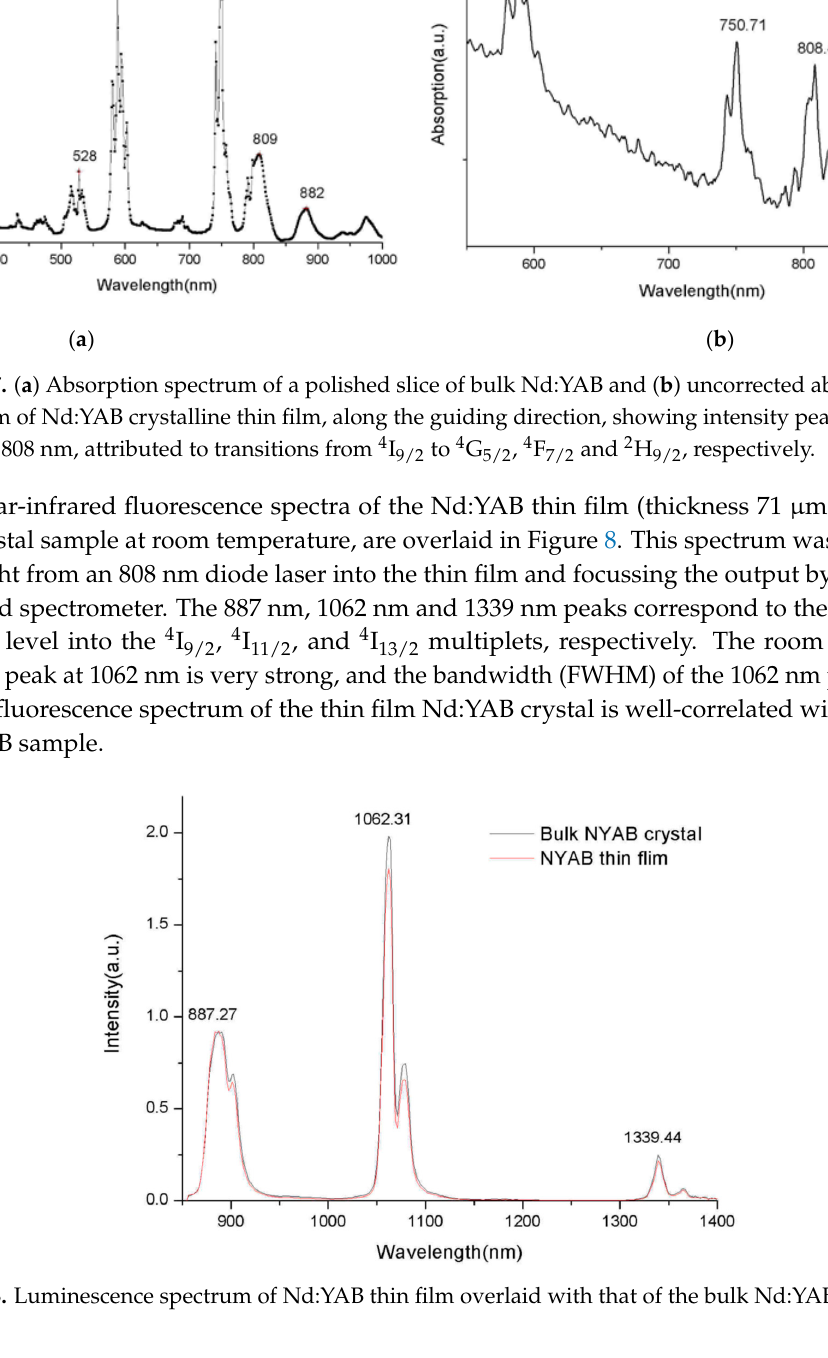
Figure 8. Luminescence spectrum of Nd:YAB thin film overlaid with that of the bulk Nd:YAB